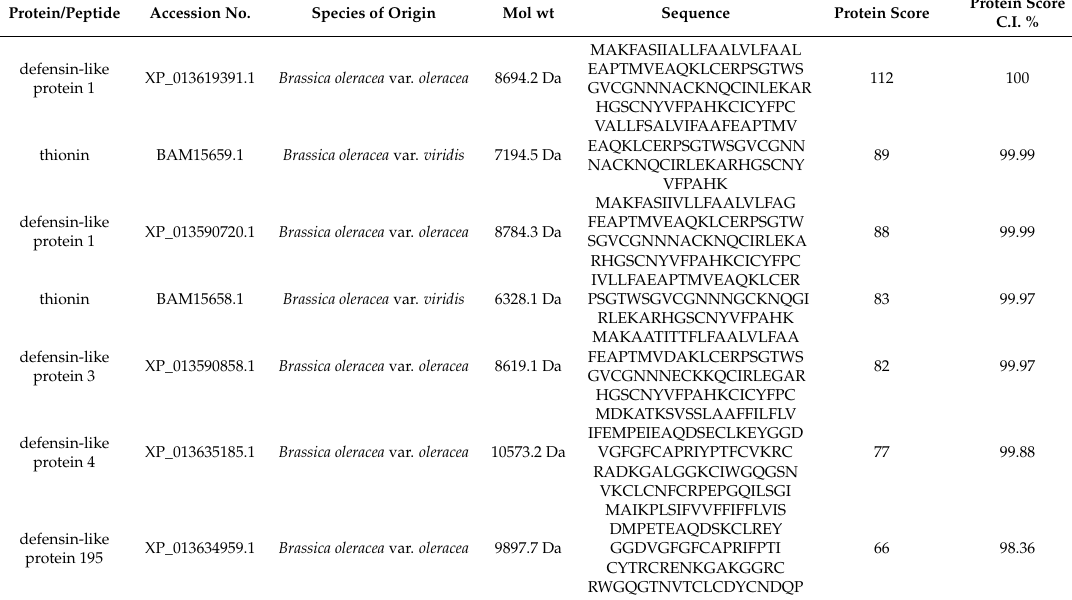
Figure 1. Purification and molecular weight determination of BGAP: ( a ) cation exchange chromatography of crude protein extract on SP-Sepharose column: ( − ): absorbance at 280 nm, (...): concentration of NaCl; ( b ) cation exchange chromatography of active fraction SP3 from SP-Sepharose column on Mono S column; ( c ) gel filtration chromatography of active fraction MS3 from Mono S column on Superdex peptide column; ( d ) Tricine-SDS-PAGE of active fraction SU3 from Superdex peptide column. Table 1. MALDI-TOF/TOF MS results of various peptides derived from BGAP.